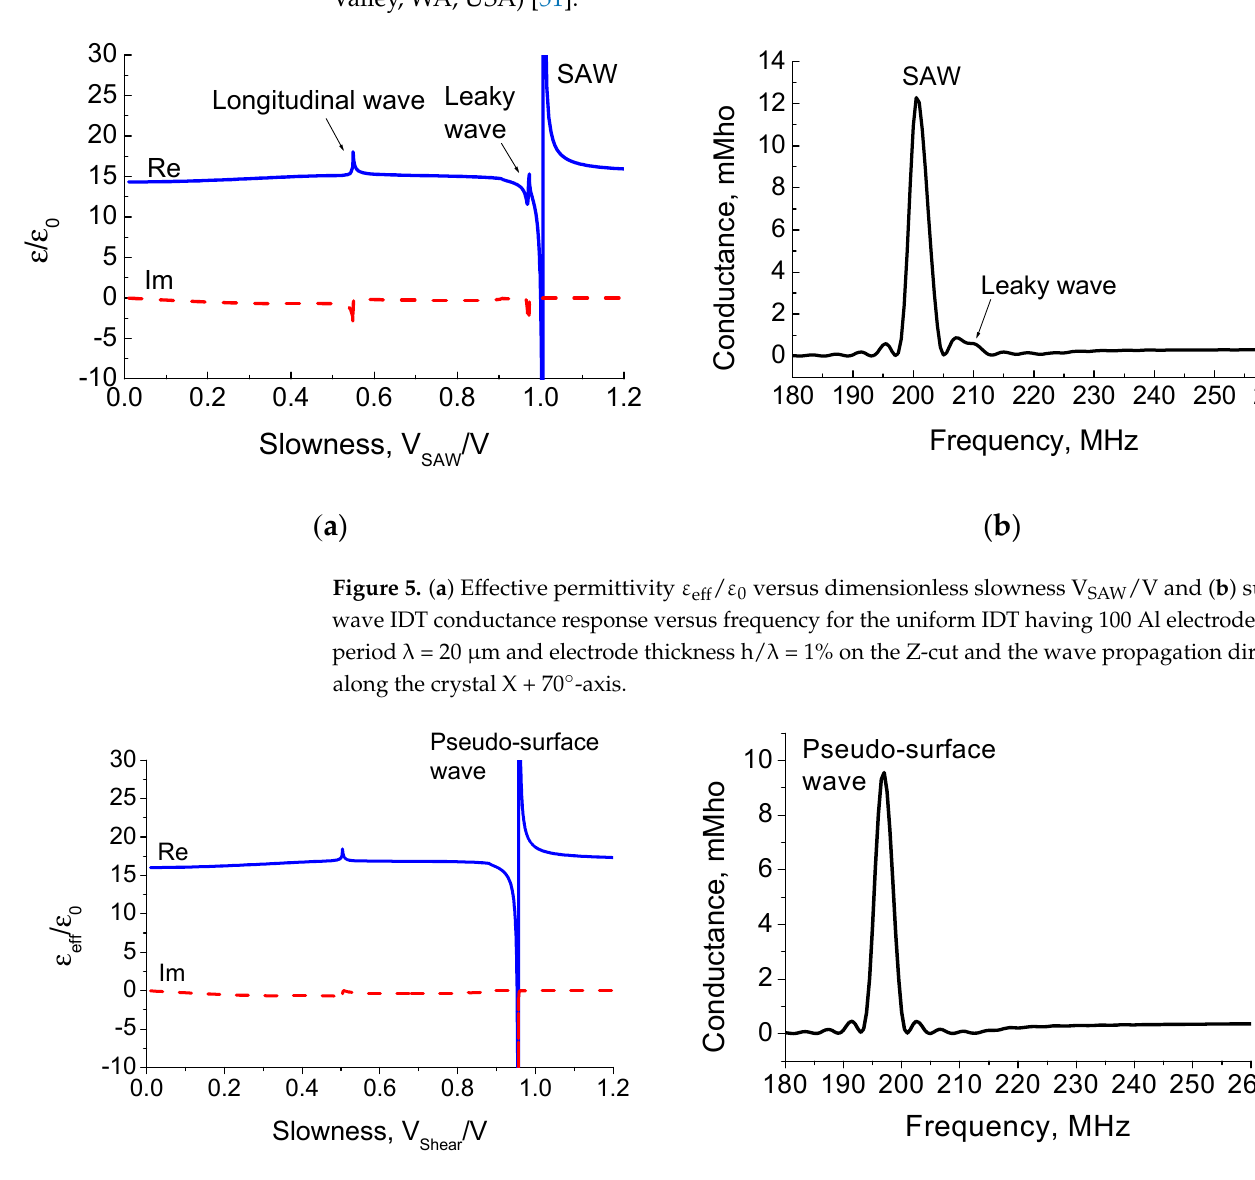
Figure 6. ( a ) Dependence of effective permittivity ε eff / ε 0 versus dimensionless slowness V Shear /V and ( b ) IDT conductance as a function of frequency for a homogeneous IDT having 100 Al electrodes with period λ = 20 μ m and electrode thickness h/ λ = 1% on the Z-cut and the pseudo-surface wave propagation direction along the crystal X-axis.